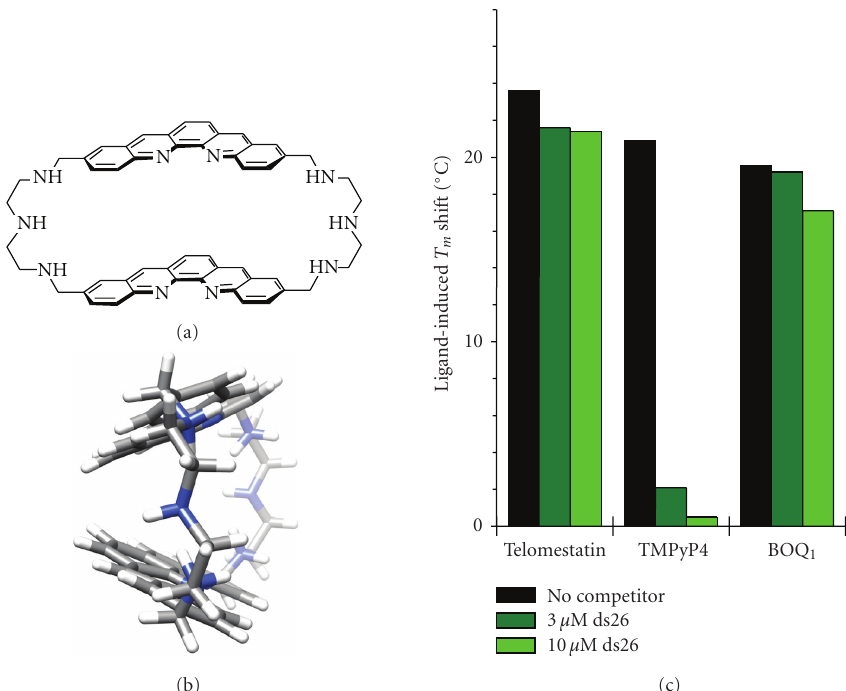
Figure 1: (a) Structure of BOQ 1 . (b) Side-view of the lowest-energy conformation of BOQ 1 during the molecular dynamic simulation. (c) FRET-melting results obtained with telomestatin, TMPyP4, and BOQ 1 (1 μ M), for experiments carried out with 0.2 μ M F21T in lithium cacodylate bu ff er (10mM, pH 7.2) with NaCl (100mM), in the absence (black bars) or in the presence of 3 (dark green bars) or 10 μ M (light green bars) of double-stranded competitor (ds26). (It is worth noting that the FRET-melting values obtained herein for BOQ 1 di ff er from that of the initial publication (see [9]). This discrepancy originates in the di ff erent experimental conditions used, given that FRET-melting is performed herein as an HTS unlike the initial report (single-cell experiment); the disparities between the two methods are extensively detailed in [15] (among which can be cited the final volume (25 versus 600 μ L), the bu ff er conditions (10mM lithium cacodylate + 100 mM NaCl versus 10 mM sodium cacodylate, 100mM LiCl),